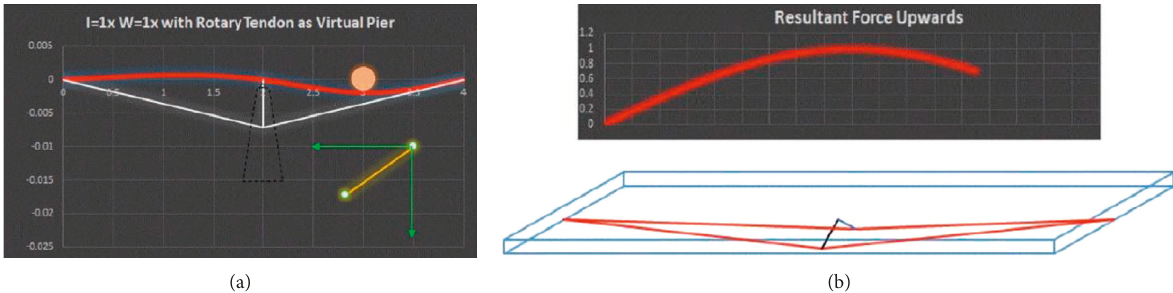
Figure 5: Rotation angle and upwards resultant force for the fourth stage of a bridge with the